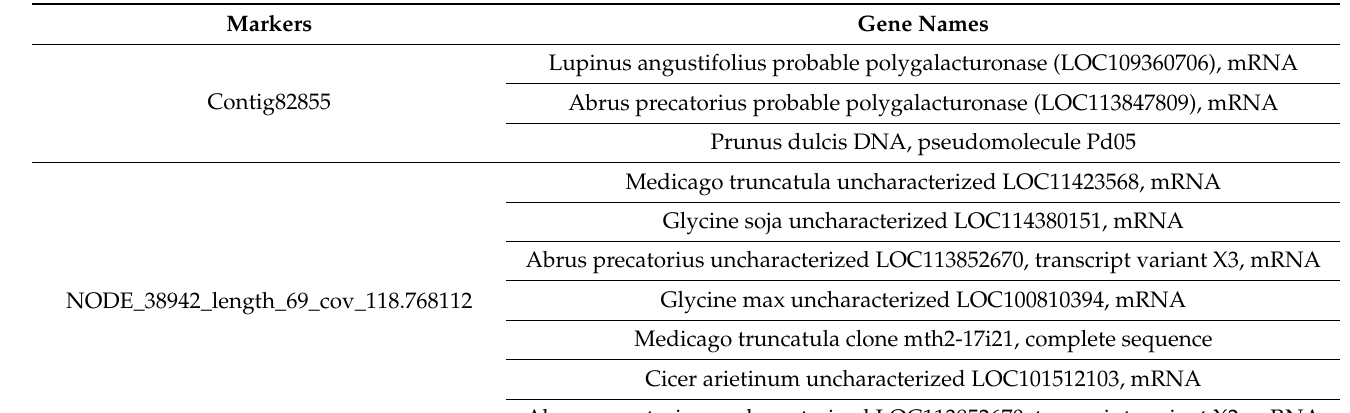
Table 7. Gene annotations of different identified SNPs markers associated with pollen